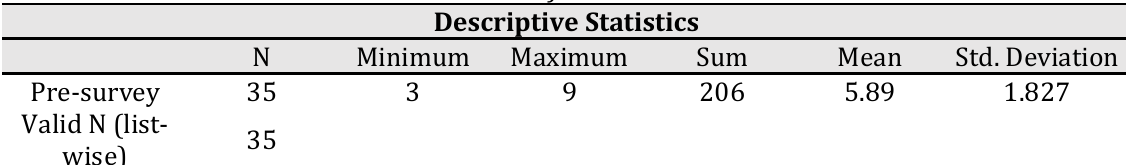
Table 19. Mean Point of Learners’ Pre -test result